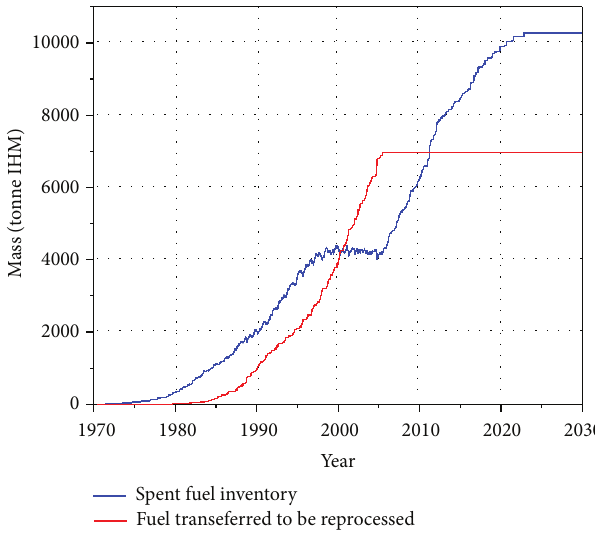
F2:Spentfuelinventoryandintegratedreprocessingthrough-